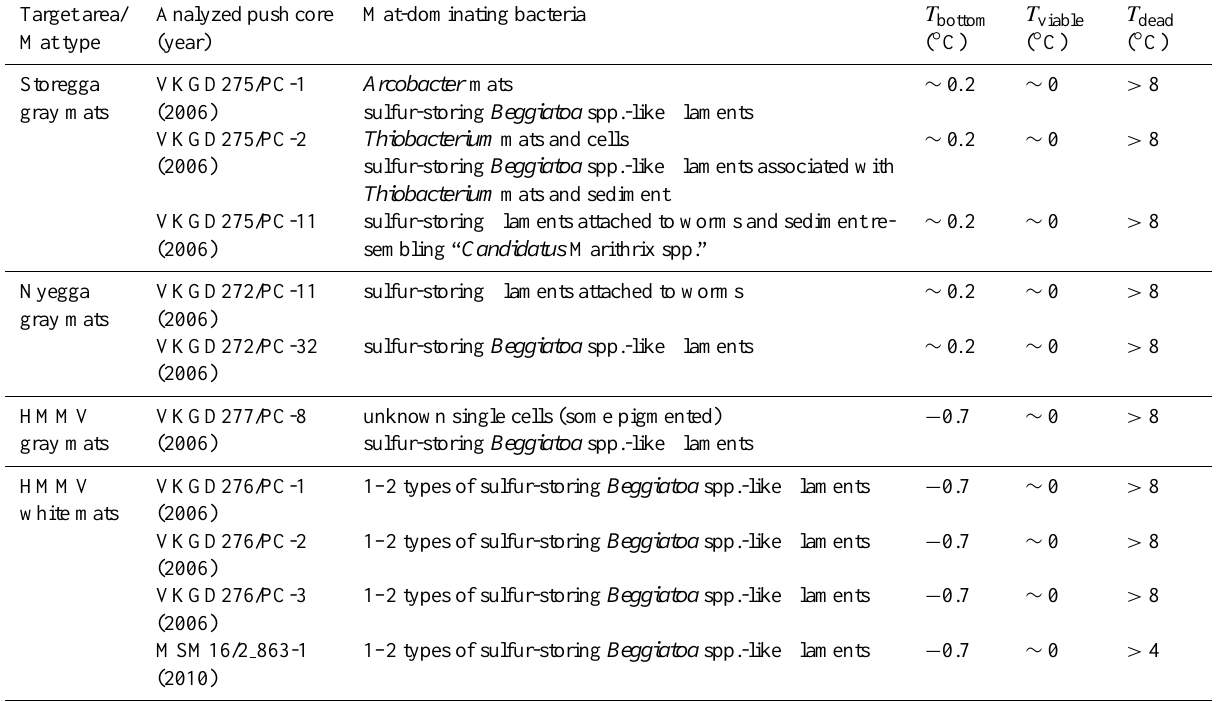
Table 3. Psychrophilic behavior of polar mat-forming thiotrophs. Target